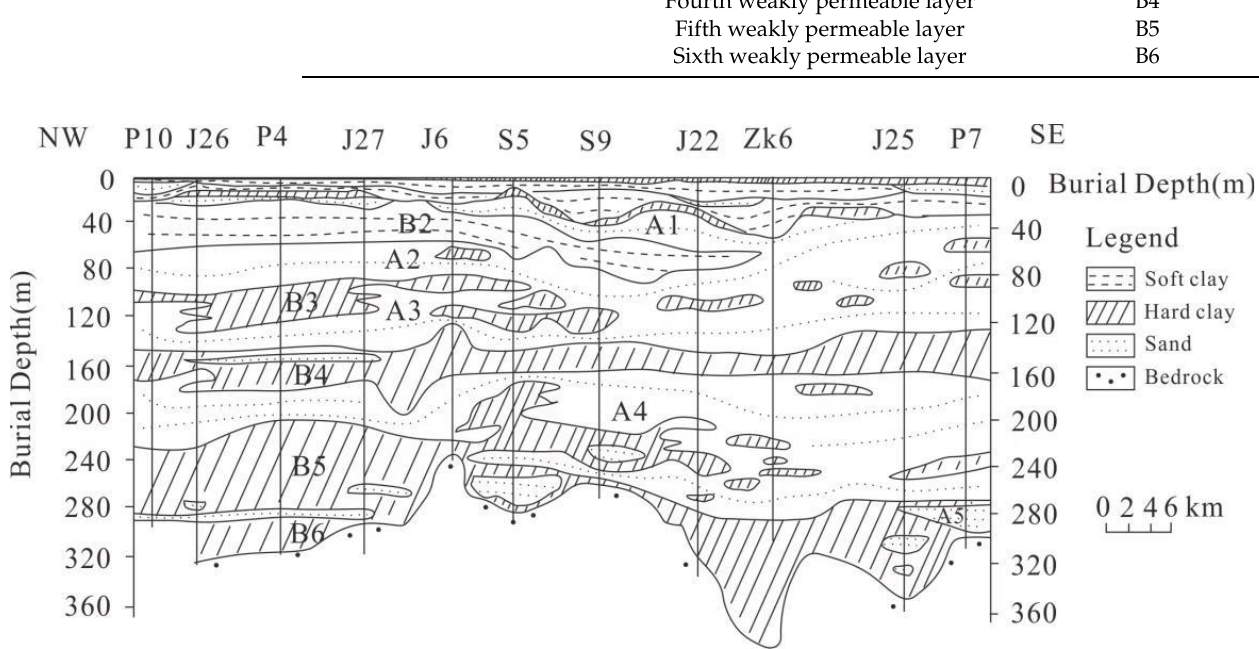
Figure 2. Hydrogeological Section Map of Shanghai City [34] .